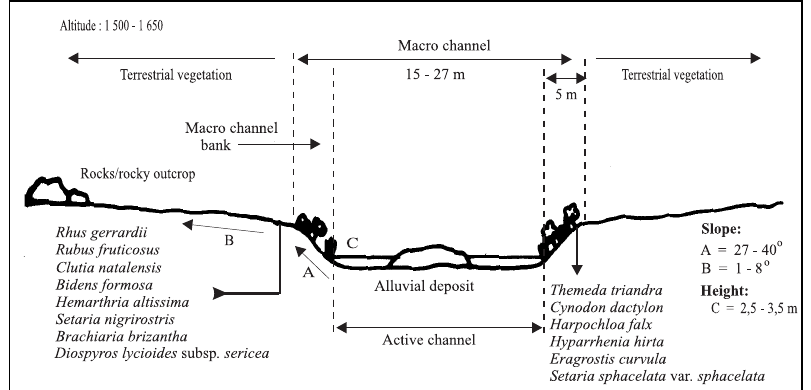
Fig. 5. River profile of the Heteropogon contortus-Cyperus longus var. tenuiflorus